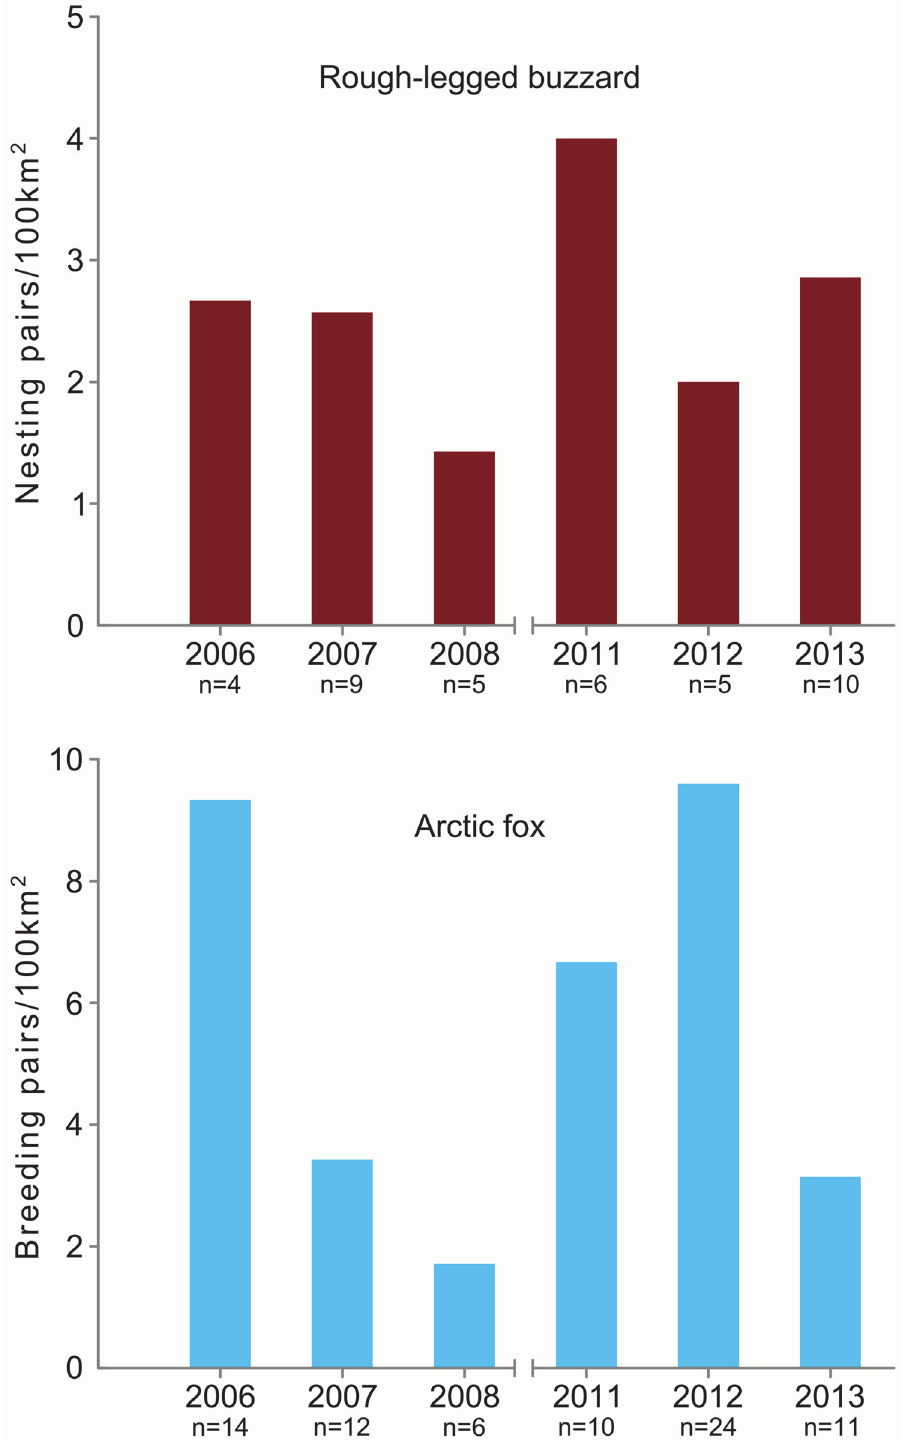
Fig 2. Density of rough-legged buzzards and arctic foxes on Kolguev Island, Russia. n — number of nesting pairs/breeding pairs documented in each year.